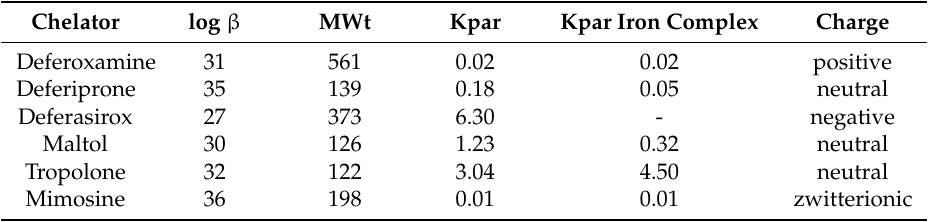
Table 2. Physicochemical properties of phytochelators and iron chelating